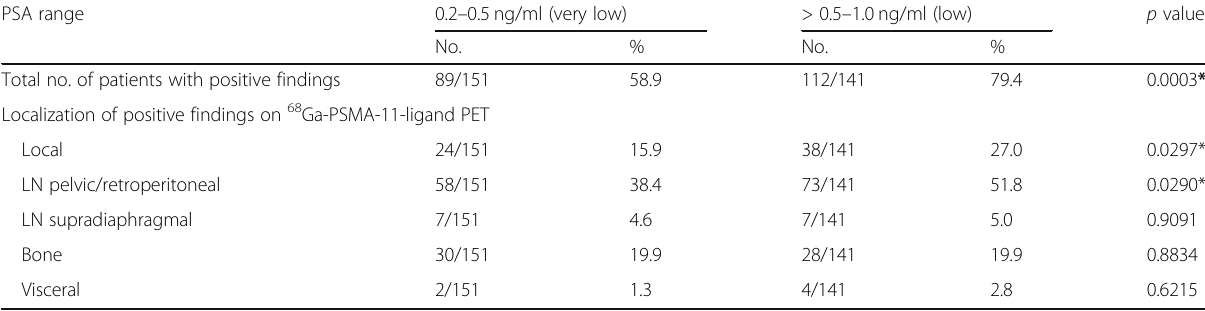
Table 3 Localization of positive findings on 68 Ga-PSMA-11-ligand PET according to PSA range PSA range